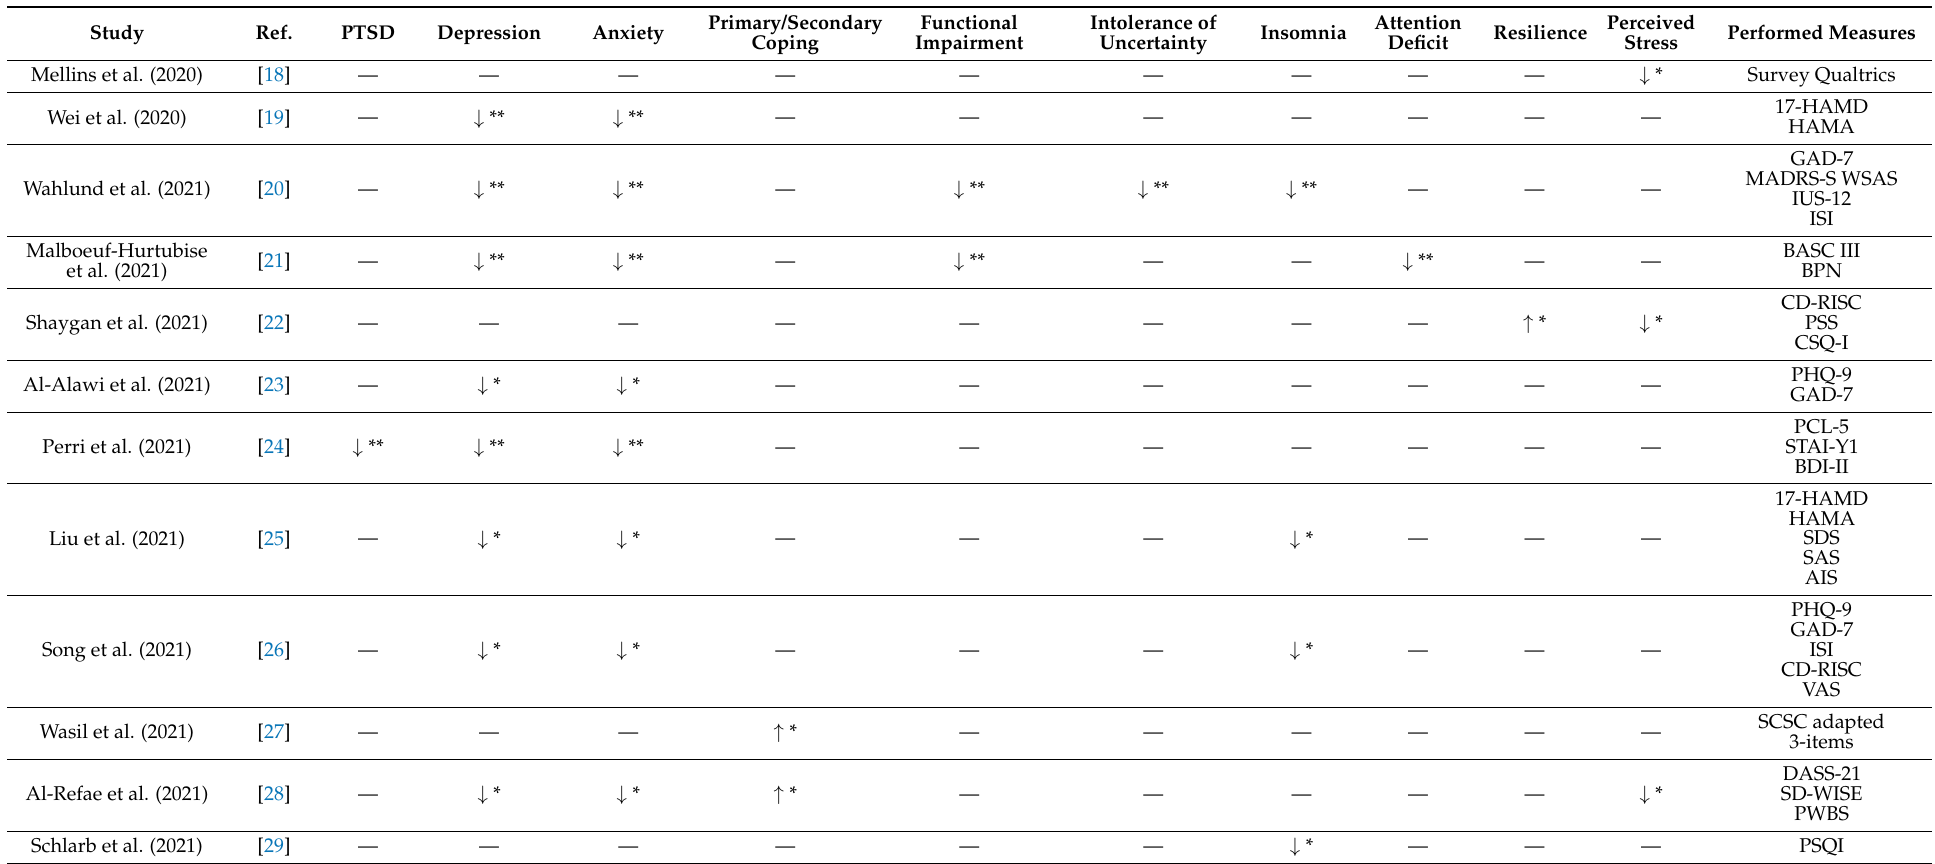
Table 2. Visual display of outcomes